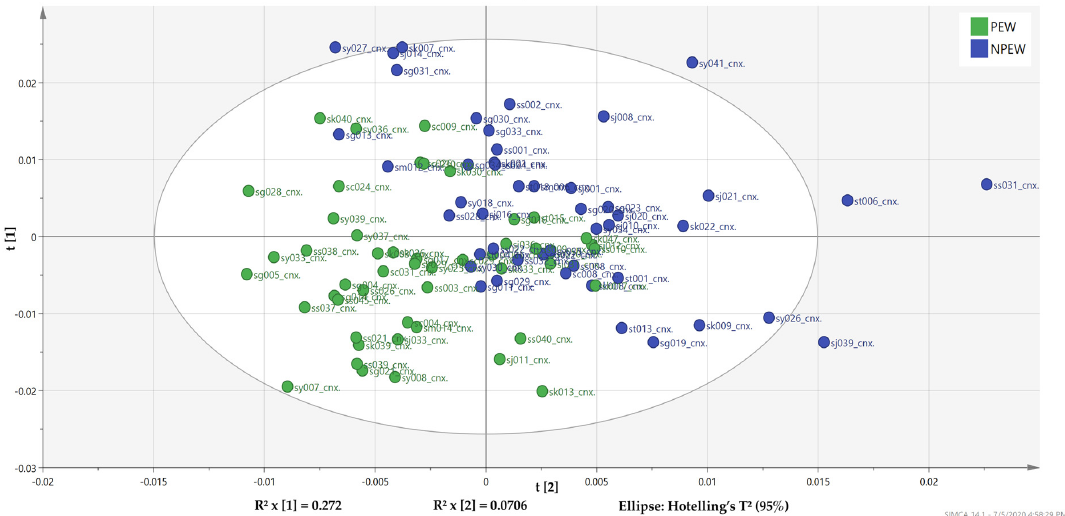
Figure 1. Characterization of the plasma metabolic changes in PEW and non-PEW hemodialysis (HD) patients. Partial least square-discriminant analysis (PLS-DA) score plot indicating metabolomics profile between the two groups (green = PEW; blue = NPEW) with each score representing one subject. The eclipse represents the 95th percentile of confidence interval, while any score outside of the eclipse is considered an outlier. Nine outlier scores were excluded from the analysis. Metabolomics profile of the two groups was clearly discriminated as indicated by a clear separation trend.